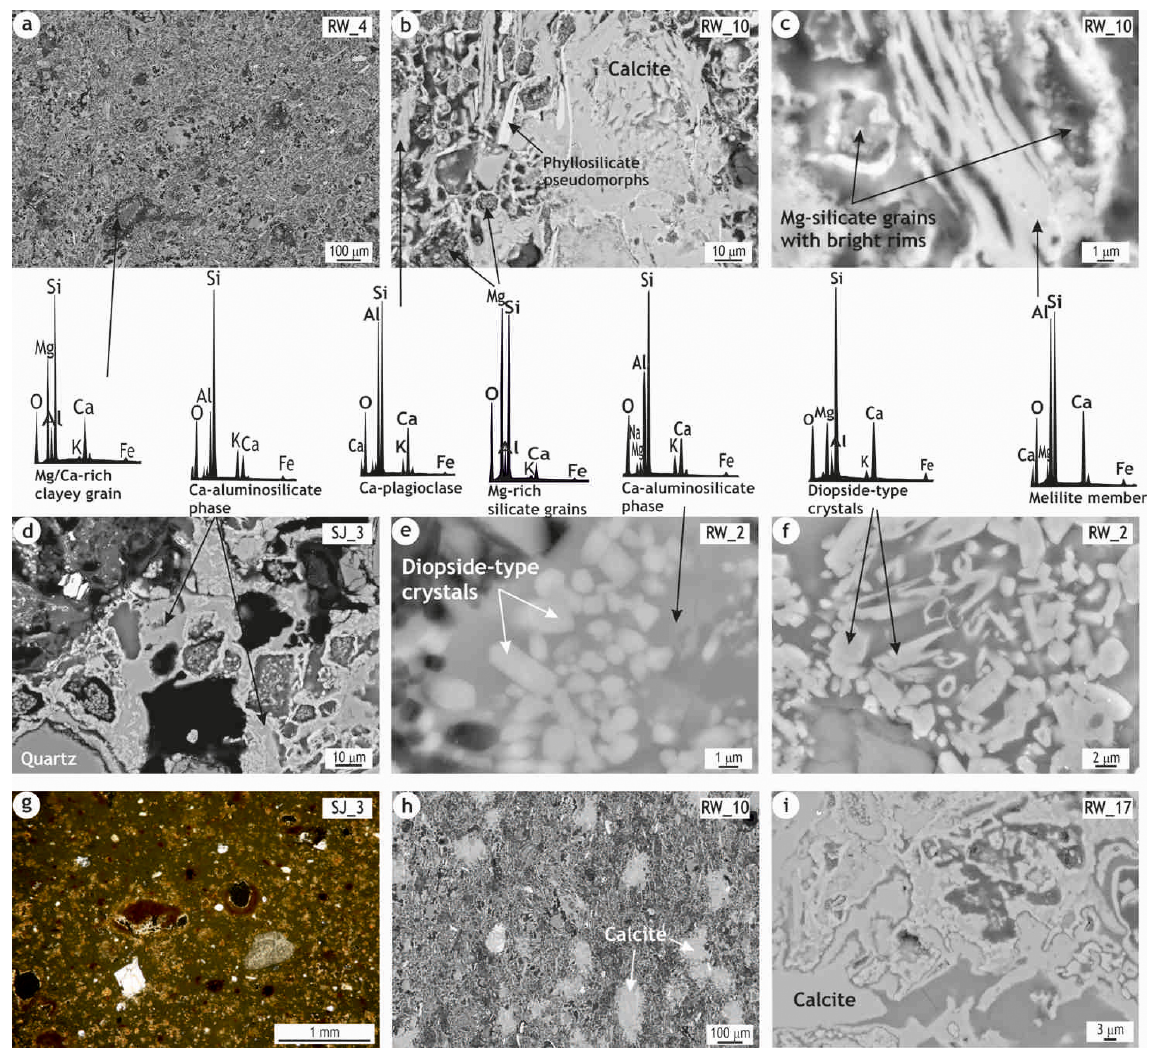
Figure 3. POM and HRSEM BSE images and associated EDS spectra showing some features of the CHCB 2 ceramic samples. (a) General view of the compact areas of the matrix where a coarse Mg-/Ca-rich clayey microcrystalline grain is observed; (b) oriented crystals of anorthite and phyllosilicate pseudomorphs and recarbonated calcite; (c) melilite member formed after the partial melting of phyllosilicate and Mg-rich silicate grains with bright reaction rims; (d) components of the brick sample bound by a Ca-aluminosilicate amorphous phase; (e, f) basal and longitudinal sections of prism-shaped and hollow skeletal crystals of diopside – with very sharp edges – nucleated from the amorphous phase, with a Ca-aluminosilicate composition; (g) sample observed by POM (cross-polarized light), in which the optically inactive portions correspond to the amorphous phase and the highly active areas mainly to clusters of recarbonated calcite crystals; (h) recarbonated calcite and (i) calcite precipitated, both through the